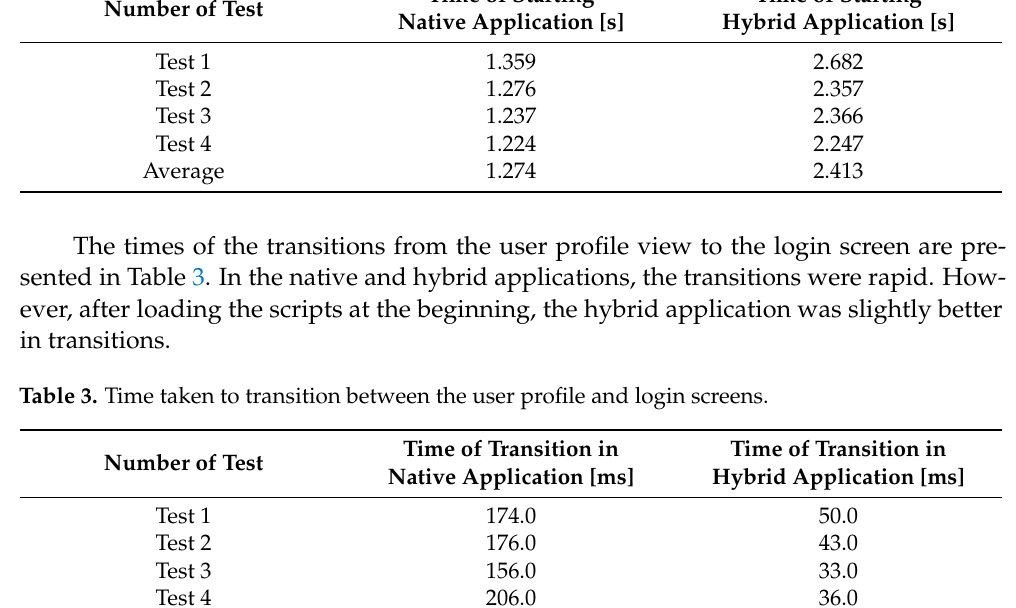
Figure 3. Average building time.